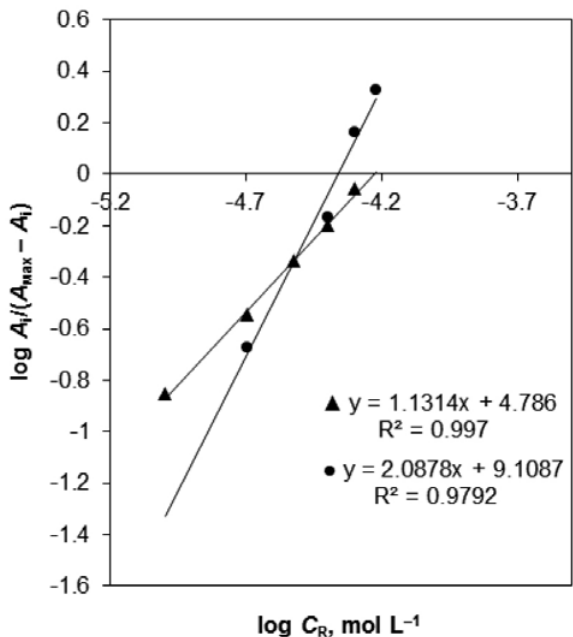
Figure 3. Straight lines by the mobile equilibrium method for determination of the molar ratios (n) Mo(VI):3,5-DTC and = 3.12 × 10 –5 mol L –1 ; C = 4.0 × 10 –1 Mo(VI):BTC C Mo(VI) H2SO4 mol L –1 ; λ = 405 nm; τ = 1 min (cid:2) Mo(VI):3,5-DNC, C = 2.4 × BTC 10 –4 mol L –1 ; n = 2; (cid:2) Mo(VI):BTC, C = 2.0 × 10 –4 mol L –1 ; 3,5-DNC n = 1